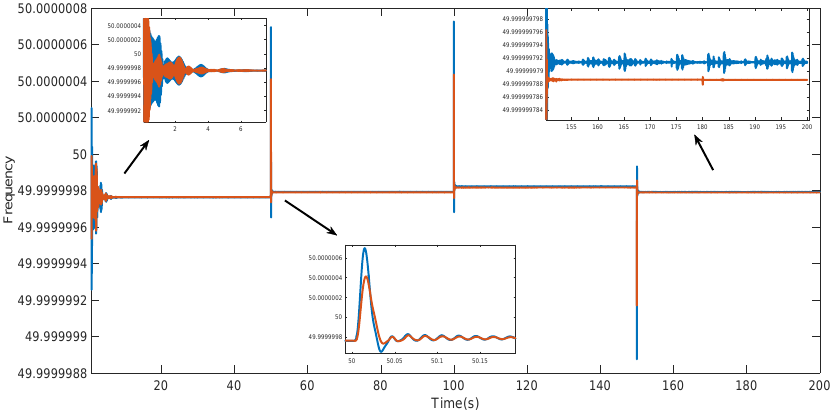
Figure 12. Wind farm exit node frequency